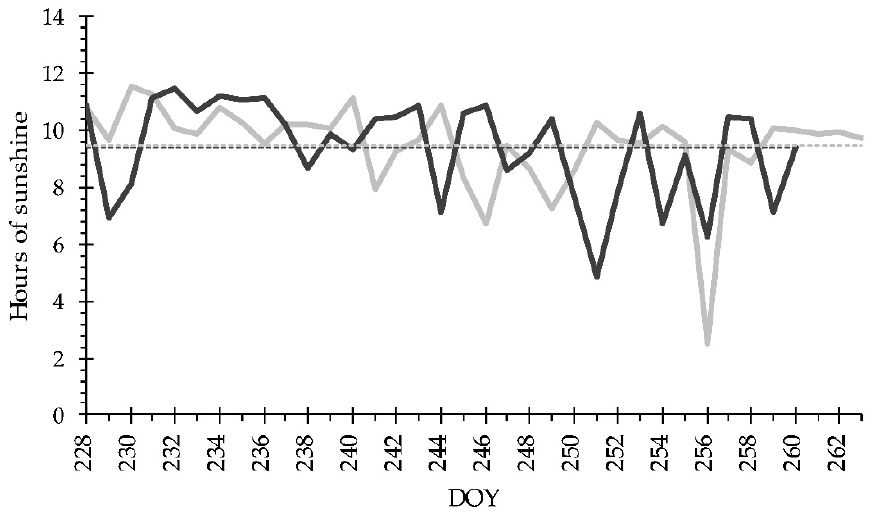
Figure 1. Hours of sunshine (hour of sunshine >120 W m − 2 ) in 2018 (light gray) and 2019 (dark gray) over the course of the experiment (in DOY). Dotted lines represent mean hours of sunshine for the years. Complete data are available via the Supplementary Materials (Table S1).